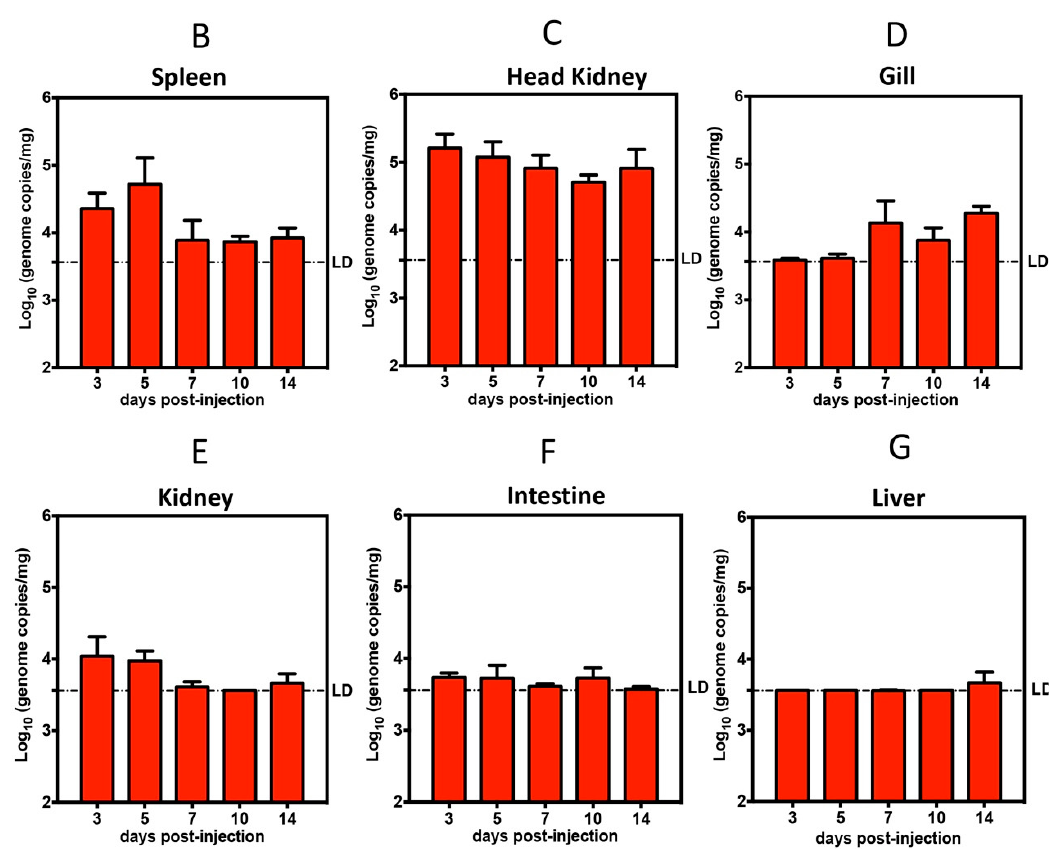
Figure 5. Pathogenicity of LYCIV-ZS-2020 on large yellow croaker. Large yellow croakers were infected intraperitoneally with LYCIVor HBSS. ( A ) The survival rate was calculated daily until 14 days post-injection for large yellow croakers infected with LYCIV (blue line) or HBSS (red line). Viral loads in different tissue samples, including spleen ( B ), Head kidney ( C ), gill ( D ), kidney ( E ), intestine ( F ), and liver ( G ) collected at 3, 5, 7, and 14 days post-injection were determined by qPCR and expressed as virus genome copies per milligram (mg) tissue sample. The limit of detection was 3.4 × 10 3 genome copies/mg. The error bars represent the standard deviation of the data. The blacked dotted line indicating the limit of detection (LD)